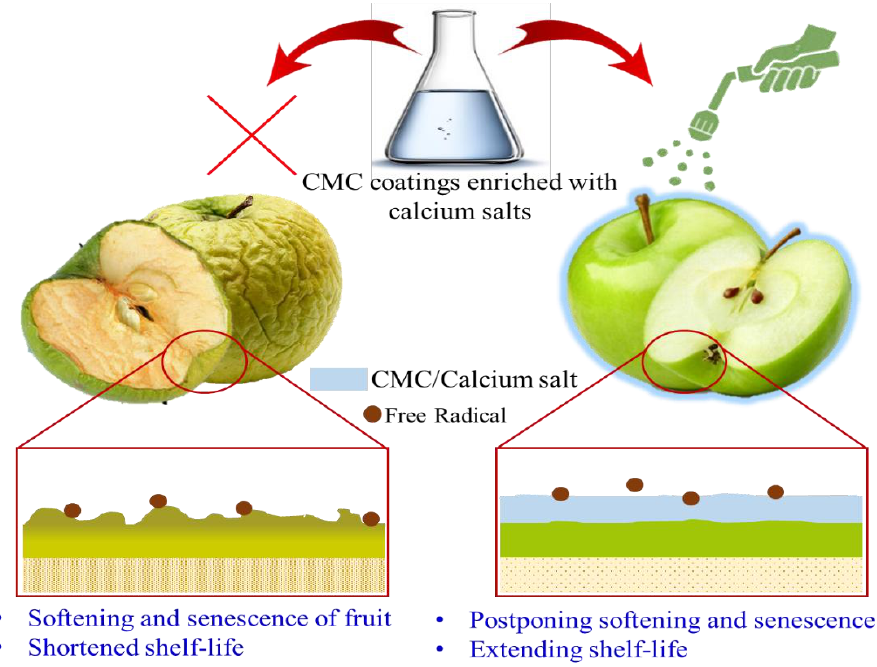
Figure 9. The use of carboxymethyl cellulose (CMC)-based coatings to protect fruit from physical and physiological damage.